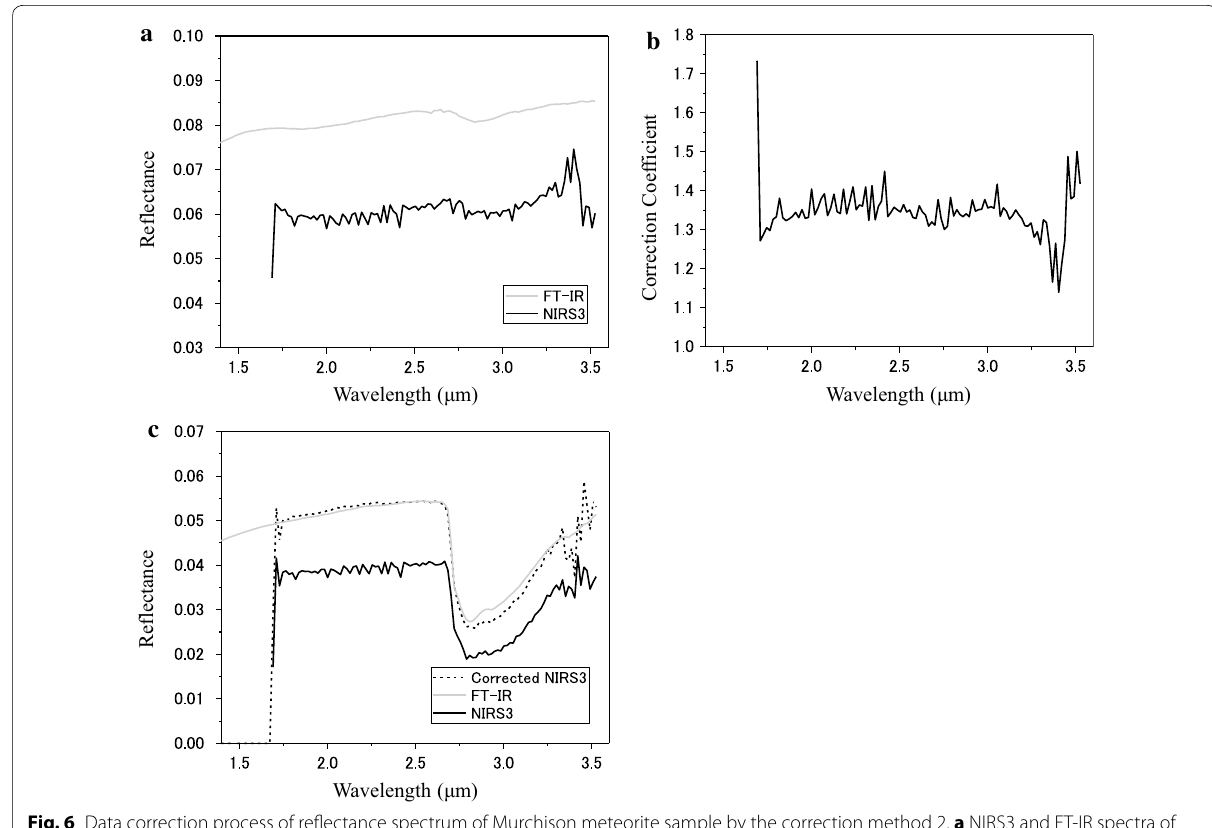
Fig. 6 Data correction process of reflectance spectrum of Murchison meteorite sample by the correction method 2. a NIRS3 and FT-IR spectra of Allende meteorite sample. b Correction coefficient based on the ratio reflectance values of Allende by FT-IR spectrometer and NIRS3 at each pixel. c FT-IR, NIRS3, and corrected NIRS3 spectra of Murchison